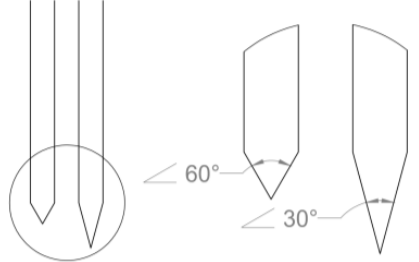
Figure 5. The opening angle of the probe is defined as the acute angle formed at the tip of the probe from edge to edge. Inset illustrates a probe with an opening angle of 60° and 30°.